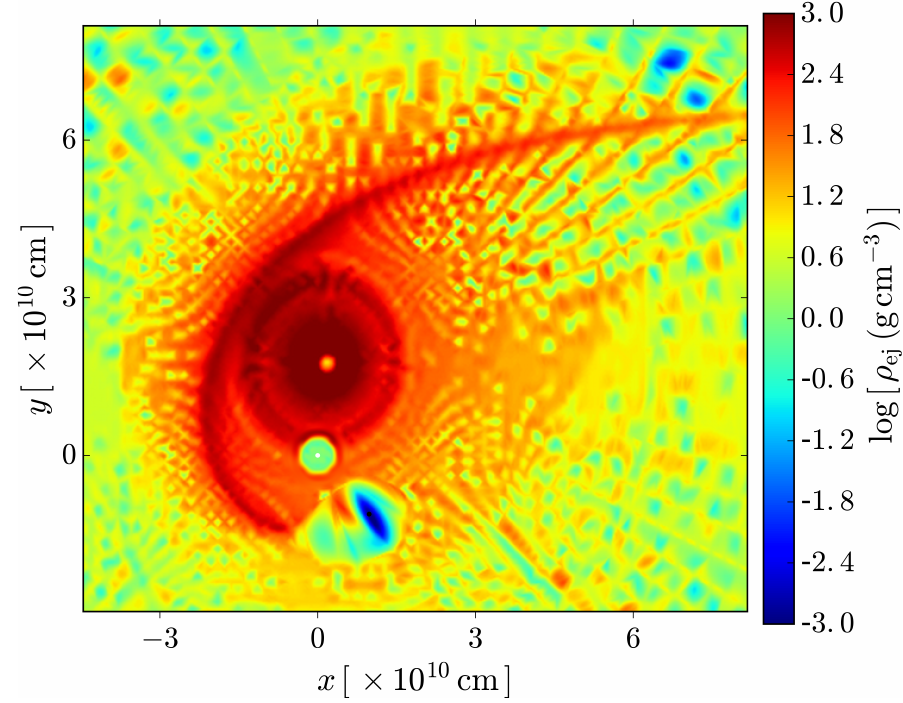
Figure 5. Snapshot of the SN ejecta density in the orbital plane of the CO core -NS binary. Numerical simulation taken from Figure 6 in [52]. The plot corresponds to the instant when the NS reaches the critical mass and forms the BH (black dot), approximately 250 s from the SN explosion. The ν NS is represented by the white dot. The binary parameters are: the initial mass of the NS companion is 2.0 M ; the CO core leading to an ejecta mass of 7.94 M , and the orbital period is P 5 min, namely ≈ (cid:12) (cid:12) a binary separation a 1.5 10 10 ≈ ×